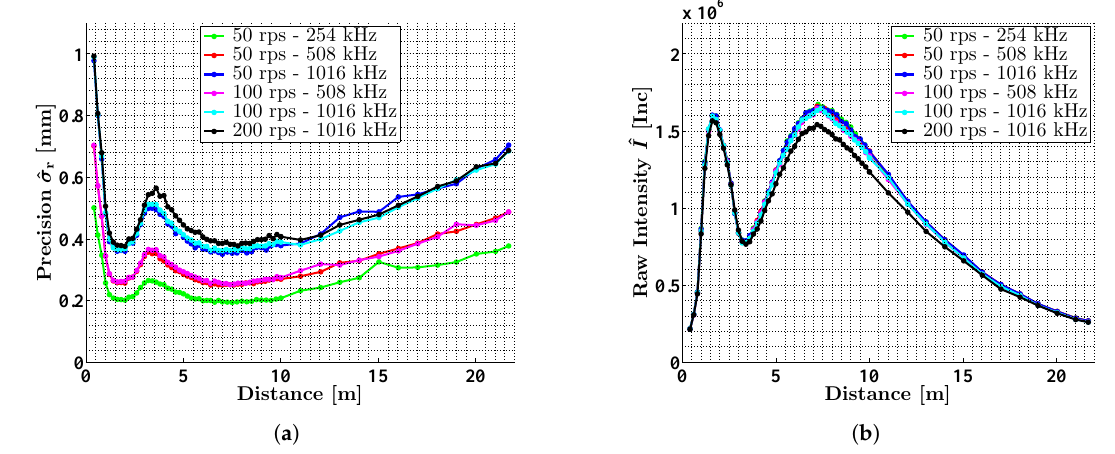
Figure 9. Precision ˆ σ r ( a ) and intensity ˆ I ( b ) of the distance measurements of the Z + F Profiler 9012A as a function of distance between sensor and object. The scans were carried out on a white planar target with all six settings of the 2D laser scanner (Table